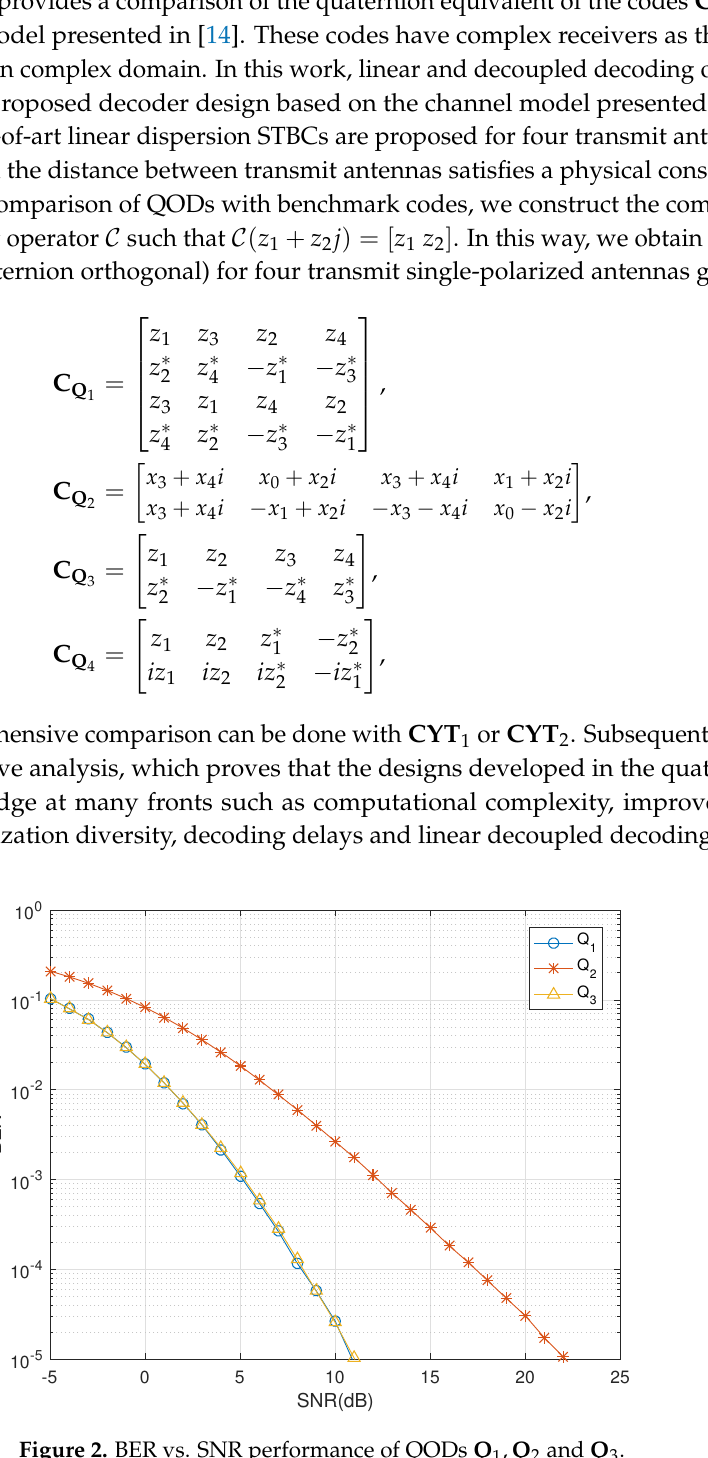
Figure 2. BER vs. SNR performance of QODs Q 1 , Q 2 and Q 3